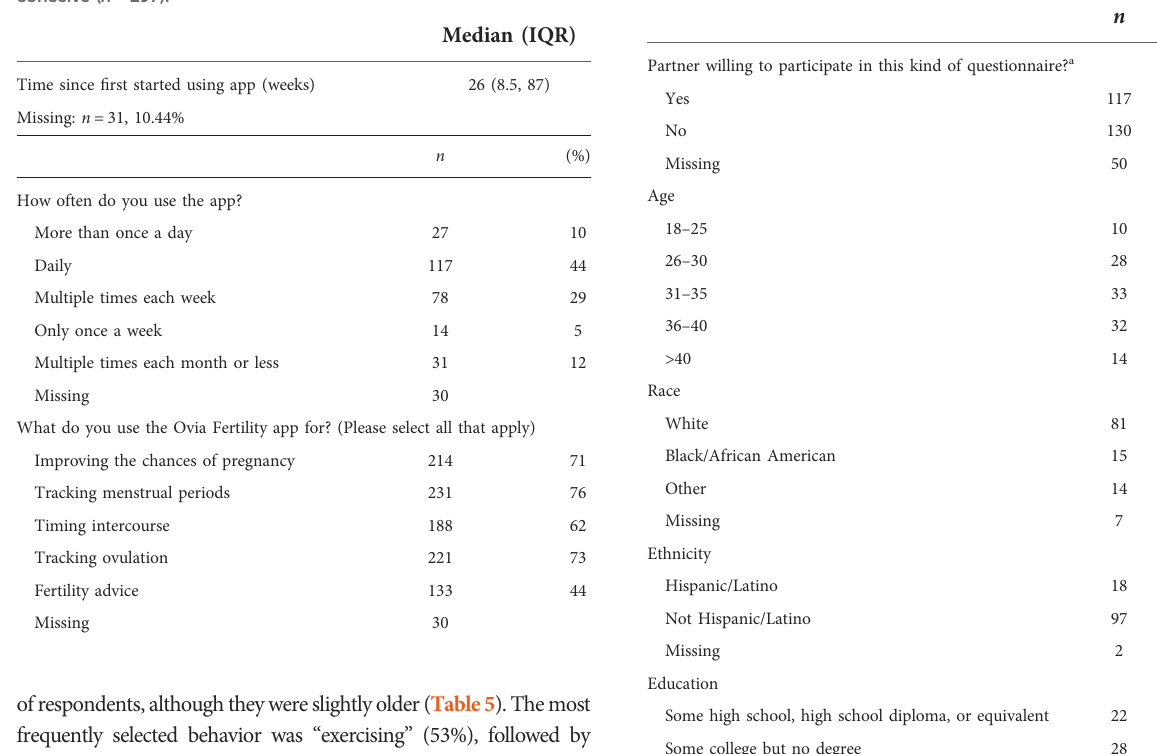
TABLE 5 Partner characteristics ( n =117). TABLE 4 Engagement with the app among those who were trying to